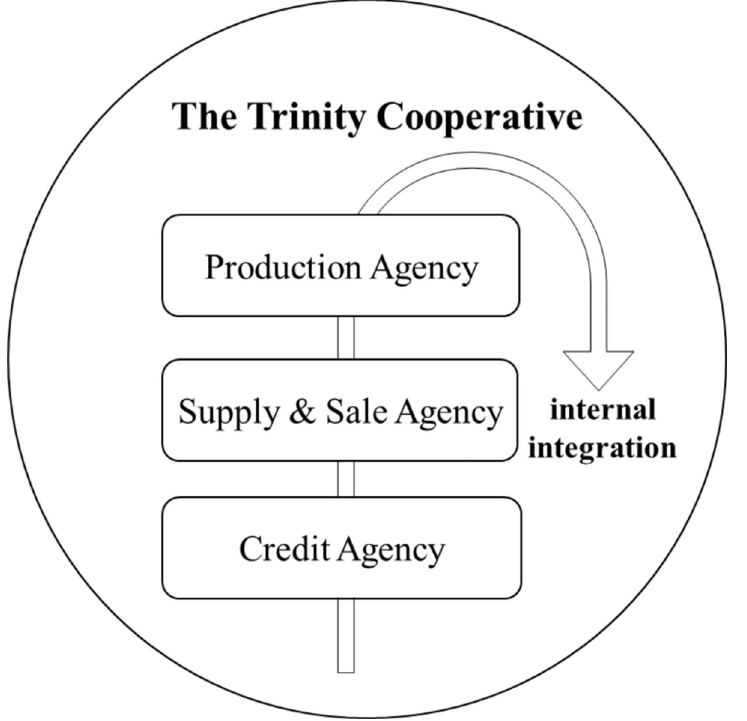
Fig 1. The internal integration of the trinity